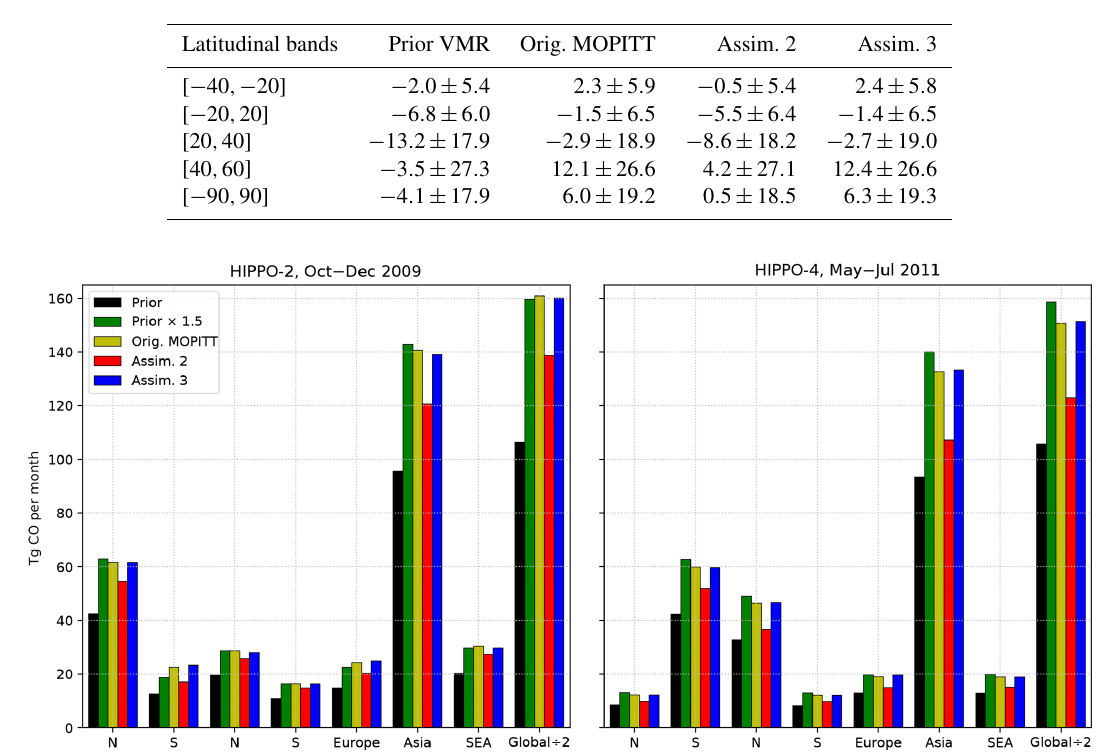
Table 5. Comparisons of GEOS-Chem-simulated mole fractions assimilating MOPITT data with HIPPO-4 observations. Uncertainties are 1 σ . Units are in parts per billion. See text for descriptions of the assimilations.